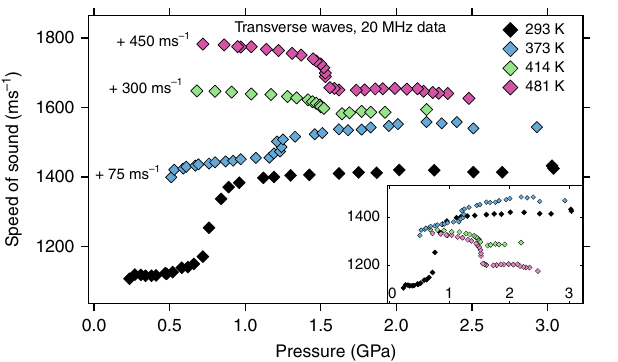
Fig. 2 Ultrasonic transverse velocities. The values at 293 K, 373 K, 414K, and 481 K are displayed with an offset by adding +75 ms − 1 (373 K), +300 ms − 1 (414 K), and +450 ms − 1 (481 K) for better clarity. The inset shows the same data without offsets. Uncertainty in pressure ( < 0.05 GPa) and speed ( < 1%) is within symbol size